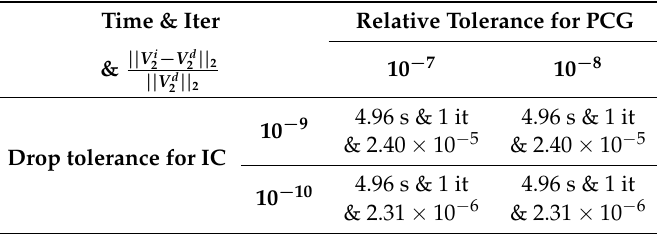
Table 4. Numerical results of Preconditioned Conjugate Gradient (PCG) with various tolerances for both Incomplete Cholesky (IC) and